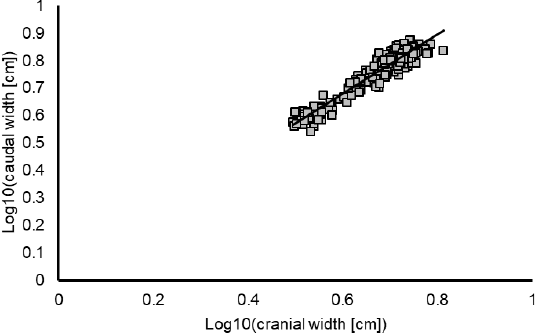
Figure 5. Strong linear correlation between body weight ( x -axis) and triangular surface ( y -axis) of female adult Xenopus laevis frogs ( n = 198; y = 0.13x + 10.11; R 2 = 0.85). There was also a strong linear correlation between the log-transformed cranial and caudal width measurements (Figure 6; R 2 = 0.91). The quotient of caudal to cranial width was significantly higher in the female frogs than in the males (means ± SD: 1.23 ± 0.07; 1.17 ± 0.06; p < 0.001).